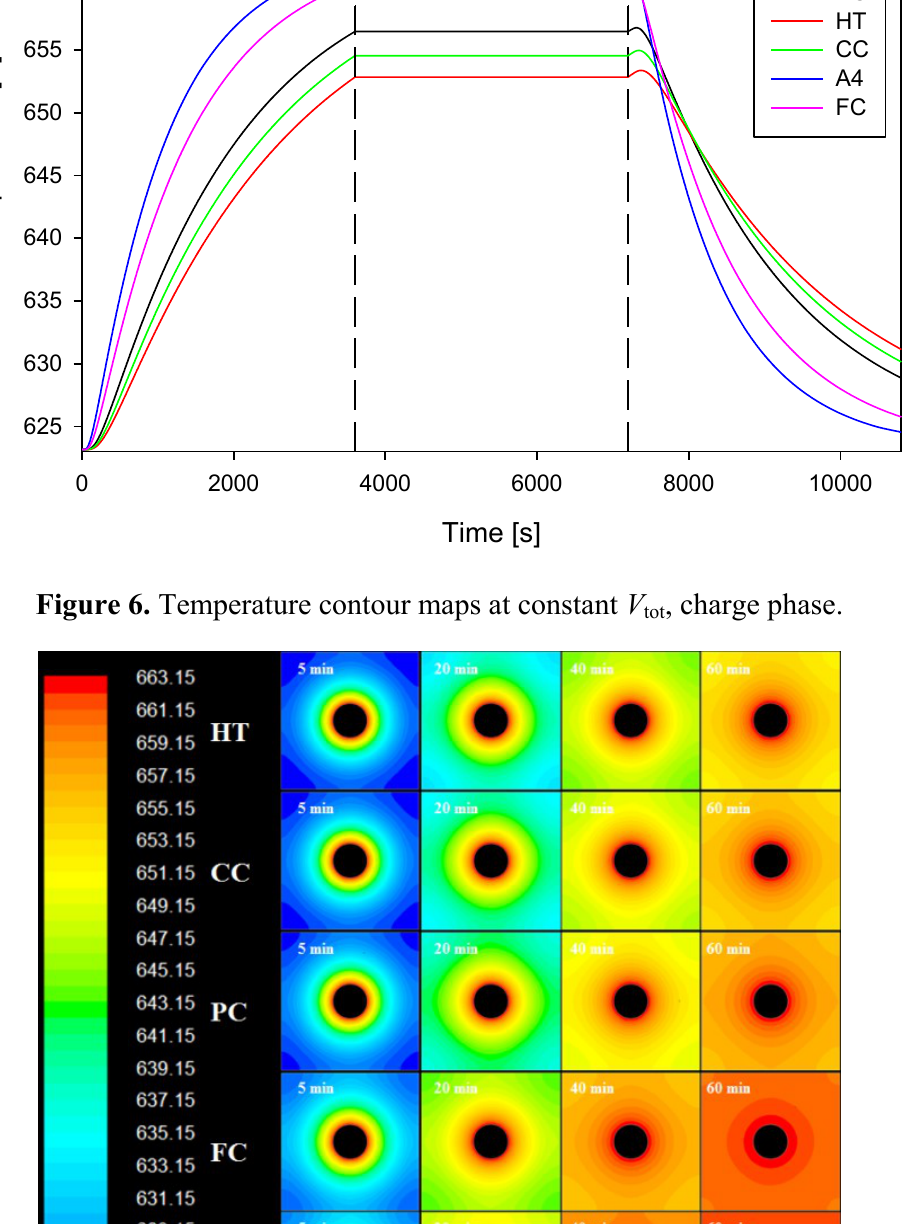
Figure 5. Temperature profile at distance d constant V . tot